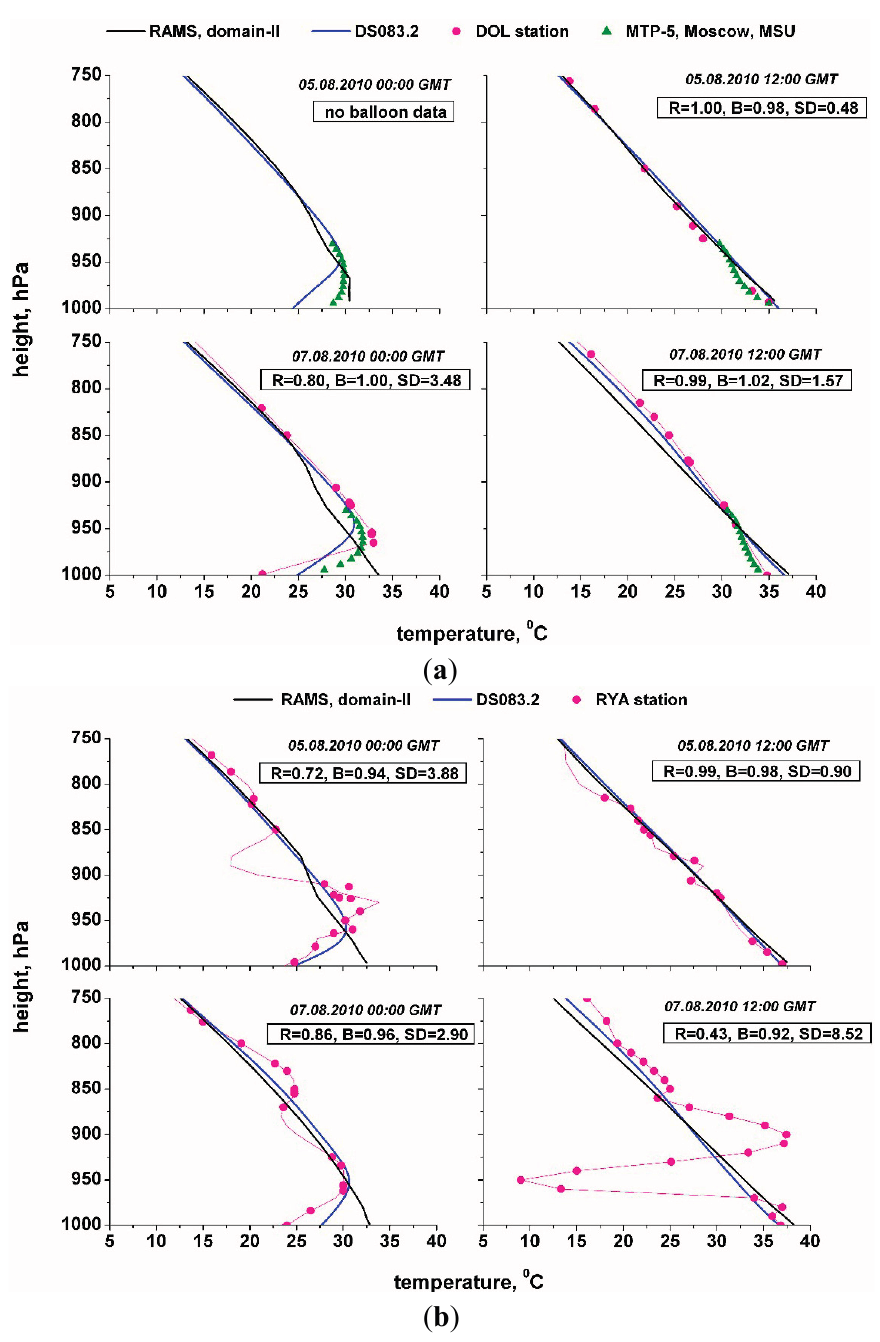
Figure 4. ( a ) Experimental balloons (DOL station) and model (RAMS/HYPACT for the domain-II) temperature profiles. In addition the MTP-5 experiential data from MSU station have been shown; ( b ) Experimental balloons (RAY station) and model (RAMS/HYPACT for the domain-II) temperature